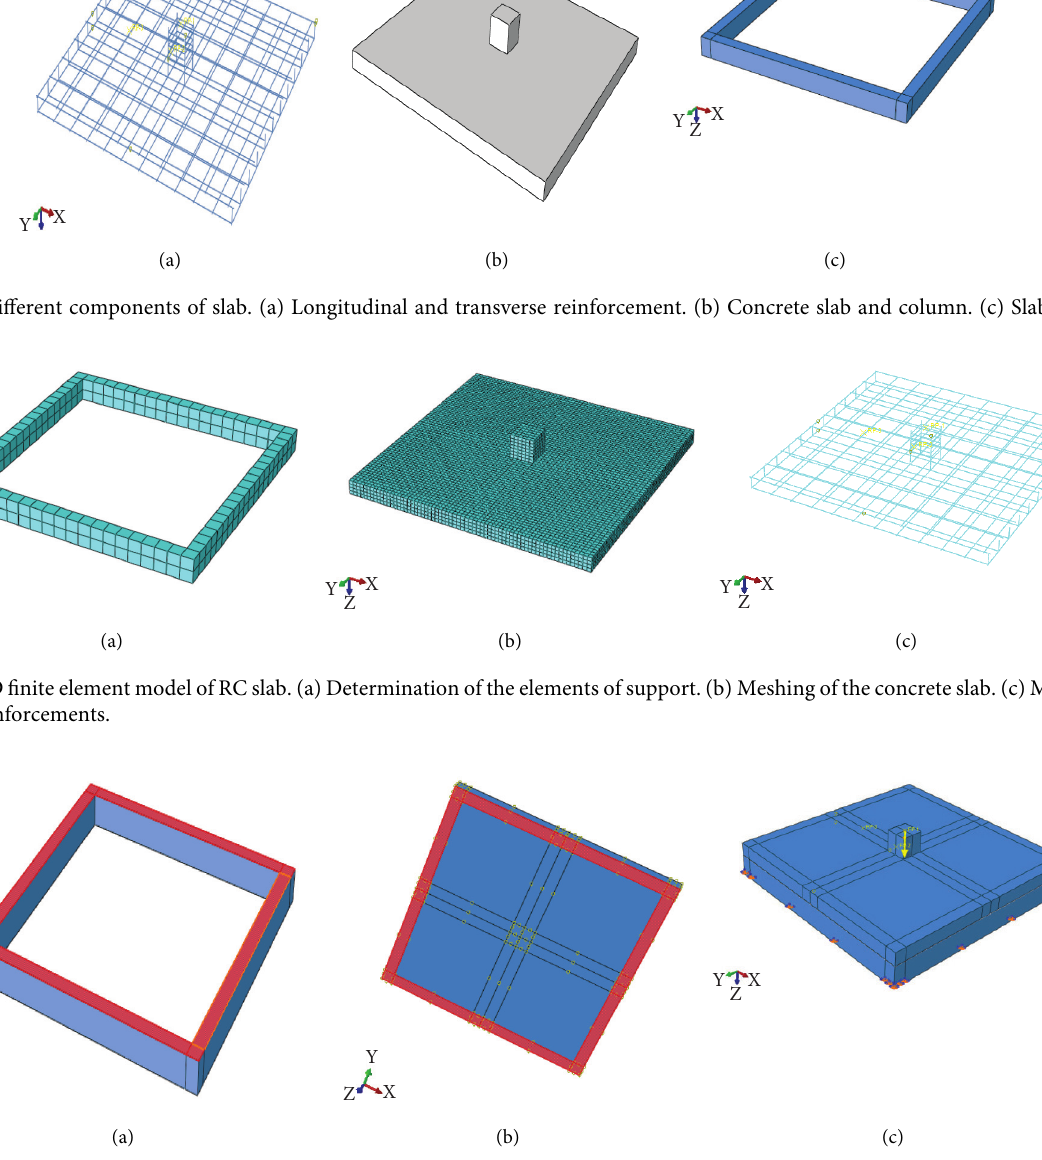
Figure 5: 3D FEM interaction and loading. (a) Master surface. (b) Slave surface. (c) Axial load